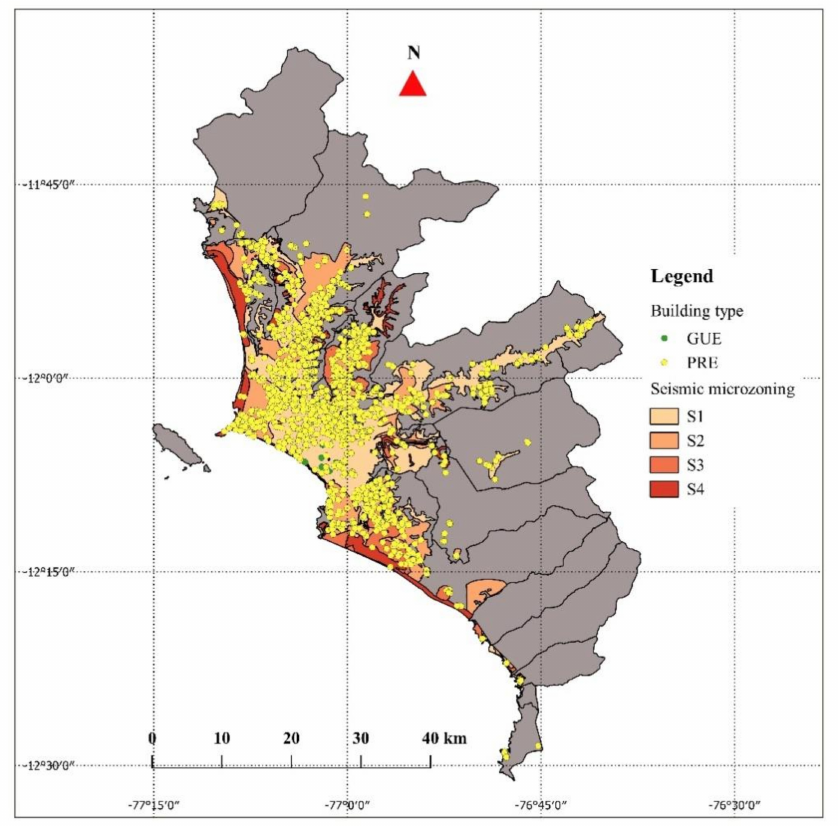
Figure 1. Public schools in Lima Metropolitan Area overlap to soil